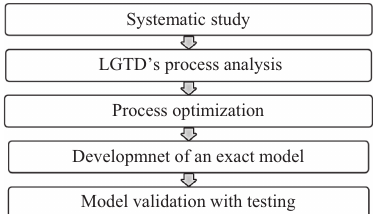
Figure 2. Research